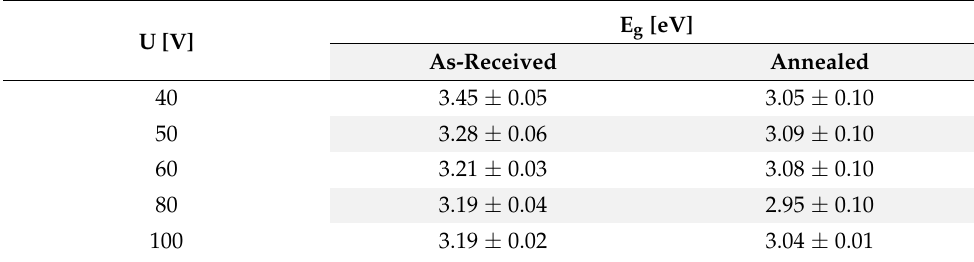
Figure 7. (F(R) hv) 0.5 vs. hv plots (Tauc plots) constructed from the UV–Vis reflectance spectra of samples anodized at 40 V ( a , c ) and 100 V ( b , d ) before ( a , b ) and after ( c , d ) thermal treatment in air at 400 °C for 2 h. Table 3. Optical band gaps determined from UV–Vis diffuse reflectance spectra (DRS) for samples anodized at different potentials (both as-anodized and annealed).